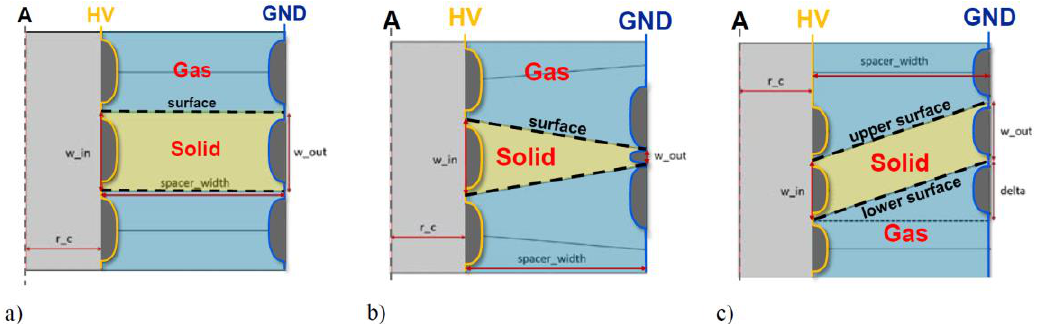
Figure 5. Geometries of ( a ) rectangular, ( b ) trapezoidal, ( c ) slanted insulators. HV conductor radius = 50 mm, spacer width = 120 mm, spacer thickness = 50 mm ( a , c ) [13].